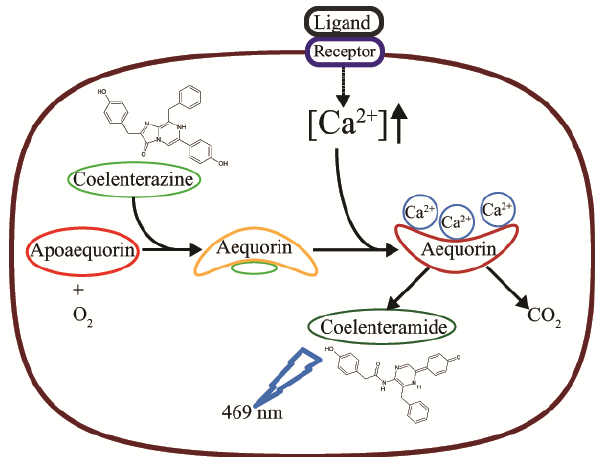
Figure 1. Mechanism of light emission by AEQ upon Ca 2+ -binding. The apoprotein (Apoaequorin) binds the prosthetic group Coelenterazine, a luciferine molecule. In the presence of oxygen, the holoprotein AEQ reconstitutes spontaneously. The EF-hand Ca 2+ -binding site on AEQ binds free Ca 2+ , which cause conformational changes in the aequorin. Through oxygenase activity, aequorin converts Coelenterazine into excited Coelenteramide and carbon dioxide. Coelenteramide relaxes to ground state by releasing blue light (469